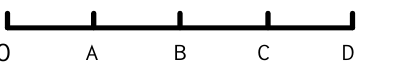
Figure 7. The selection of the original points.